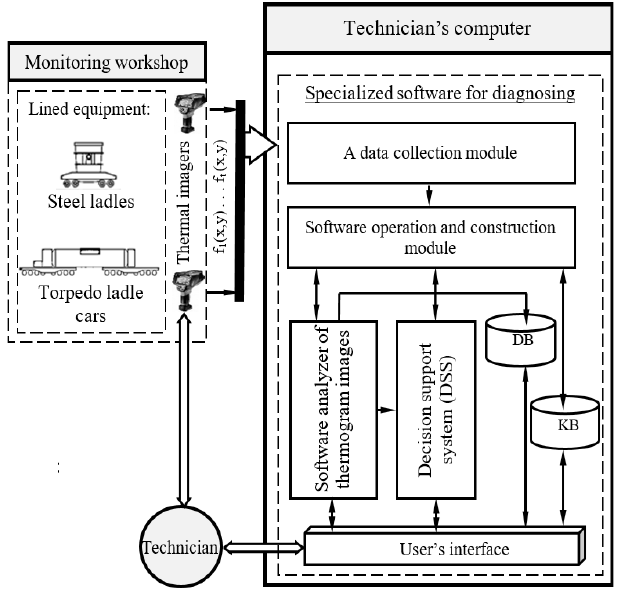
Figure 3. The structure of a diagnostic system with a specialized software.